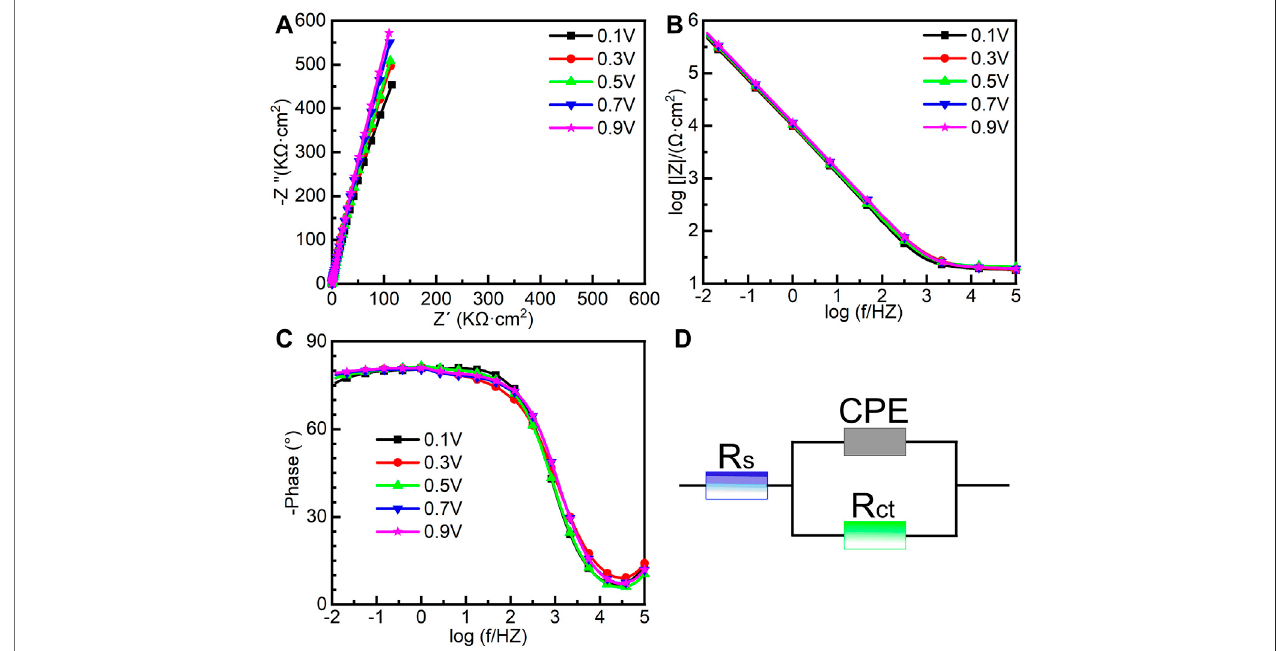
FIGURE6| Electrochemicalimpedancespectroscopy ofas-cast Ti-6Al-4V underdifferent fi lmformationpotentials inpassivationrange inHank ’ ssolutionat37 ° C, (A) Nyquist plots, (B) Bode impedance plots, (C) Bode phase diagram and (D) equivalent circuit.